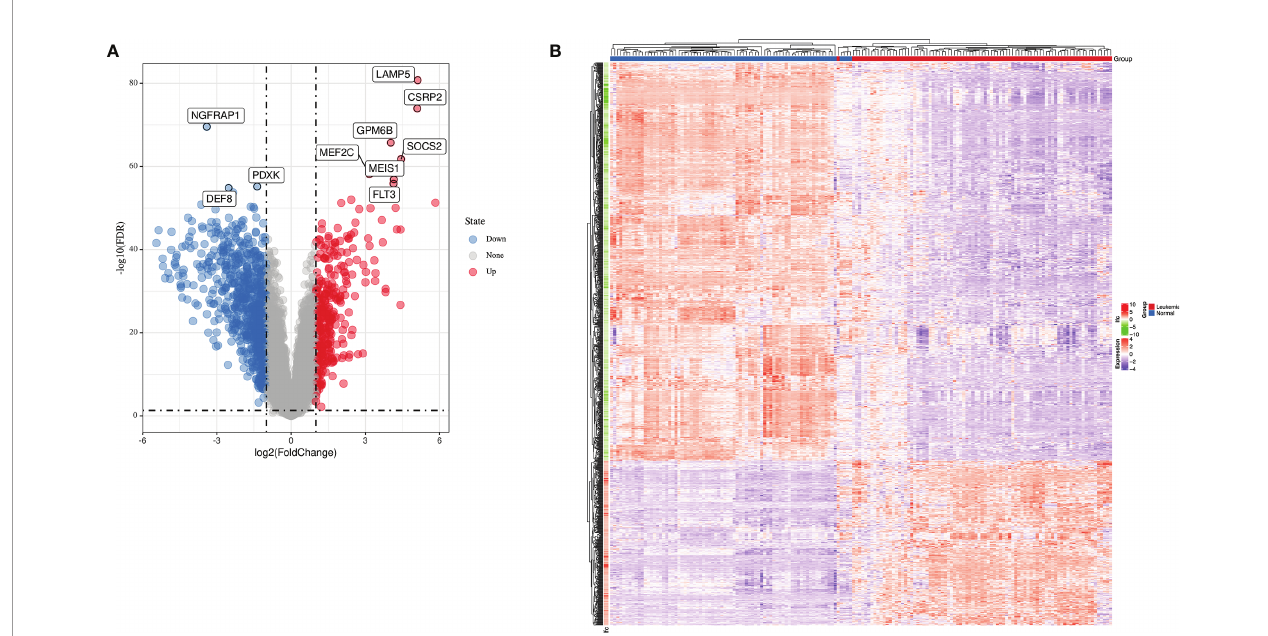
FIGURE 1 | The expression pro fi les of MLL -r ALL. (A) Volcano map of differently expressed genes between MLL -r ALL and normal samples. (B) Heatmap of the DEGs according to the value of